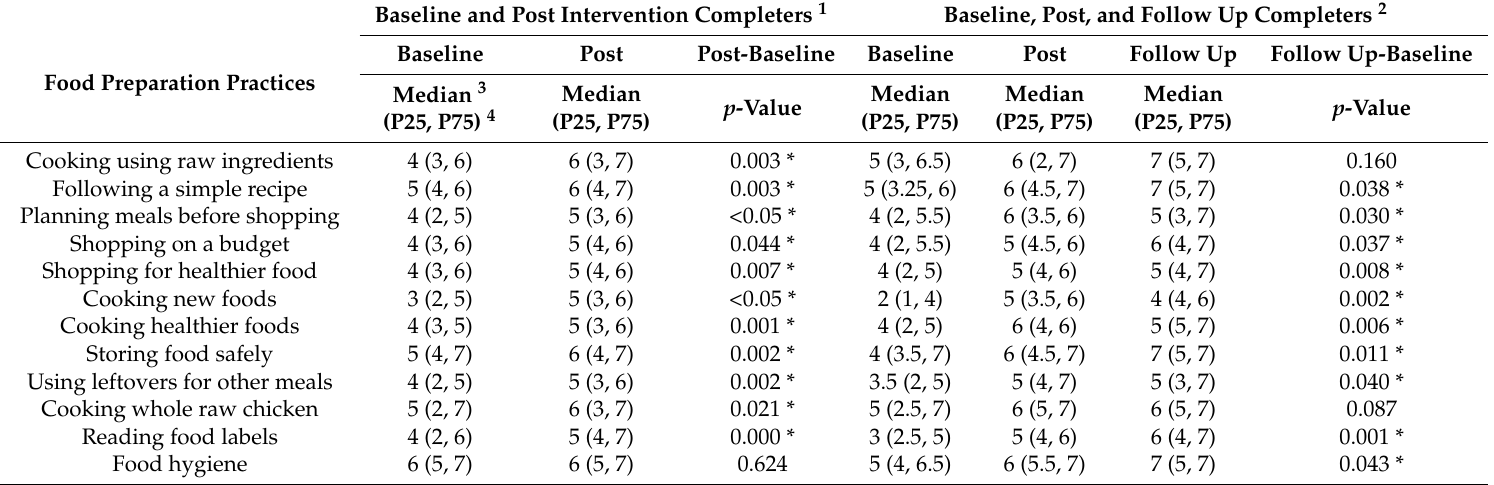
Table 6. Confidence ratings for preparation and cooking practices at baseline and post intervention ( n = 62) and 3–4 month follow-up ( n = 17).